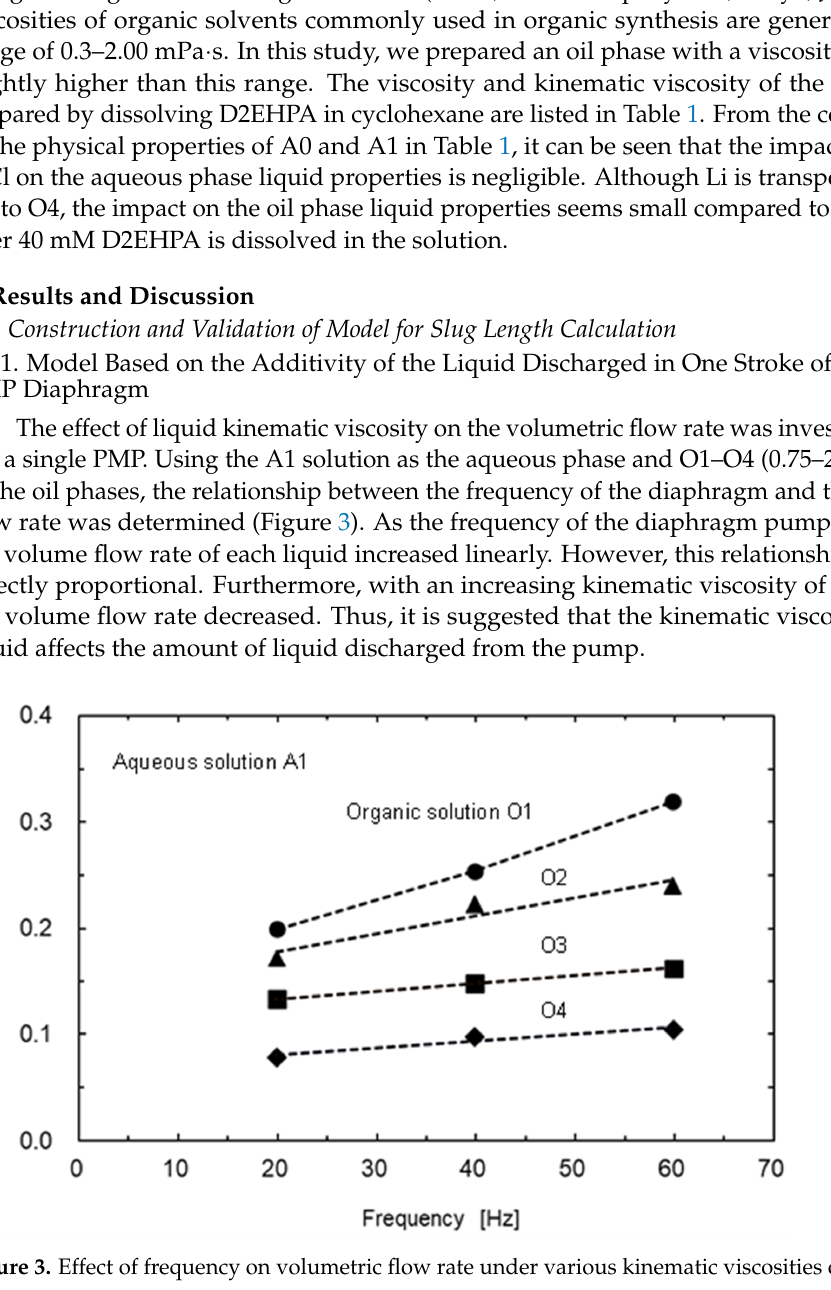
Figure 4. Slug lengths of ( a ) aqueous phase and ( b ) oil phase under various volumetric flow rates and frequencies. Solid line: computed using Equation (1); dashed line: computed based on the ef- fective frequency shown in Figures 5 and 6. We considered the equation for the slug length generated by the PMP. If the slug length is (cid:1838) (cid:3036) [mm], the volumetric flow rate is (cid:1848) (cid:3036) [mL/s], and the set frequency of the de- vice is f [Hz], Equation (1) can be established as follows: (cid:1848) (cid:3036) = (cid:1858) × (cid:1874) (cid:3036)